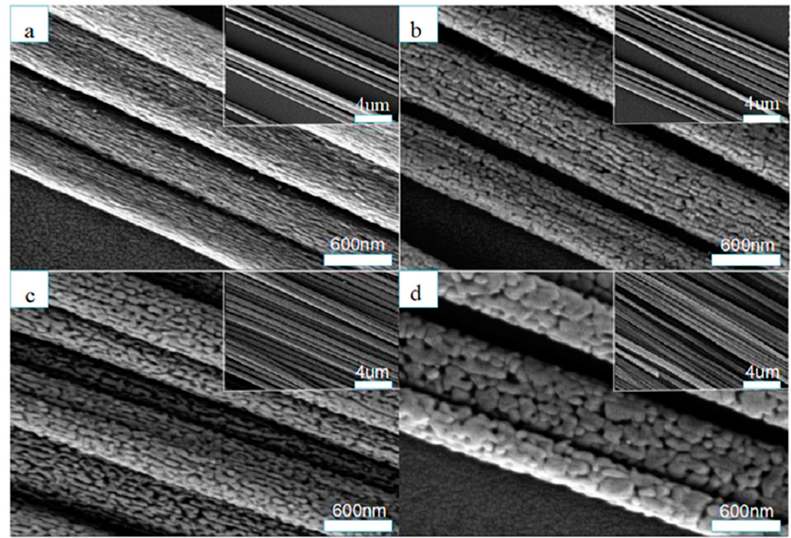
Figure 7. SEM images of aligned TiO 2 NWs calcinated at different temperatures: ( a ) 500 °C, ( b ) 600 °C, ( c ) 700 °C and ( d ) 800 °C. Reprinted with permission from Ref. [56], Copyright 2019 Elsevier.